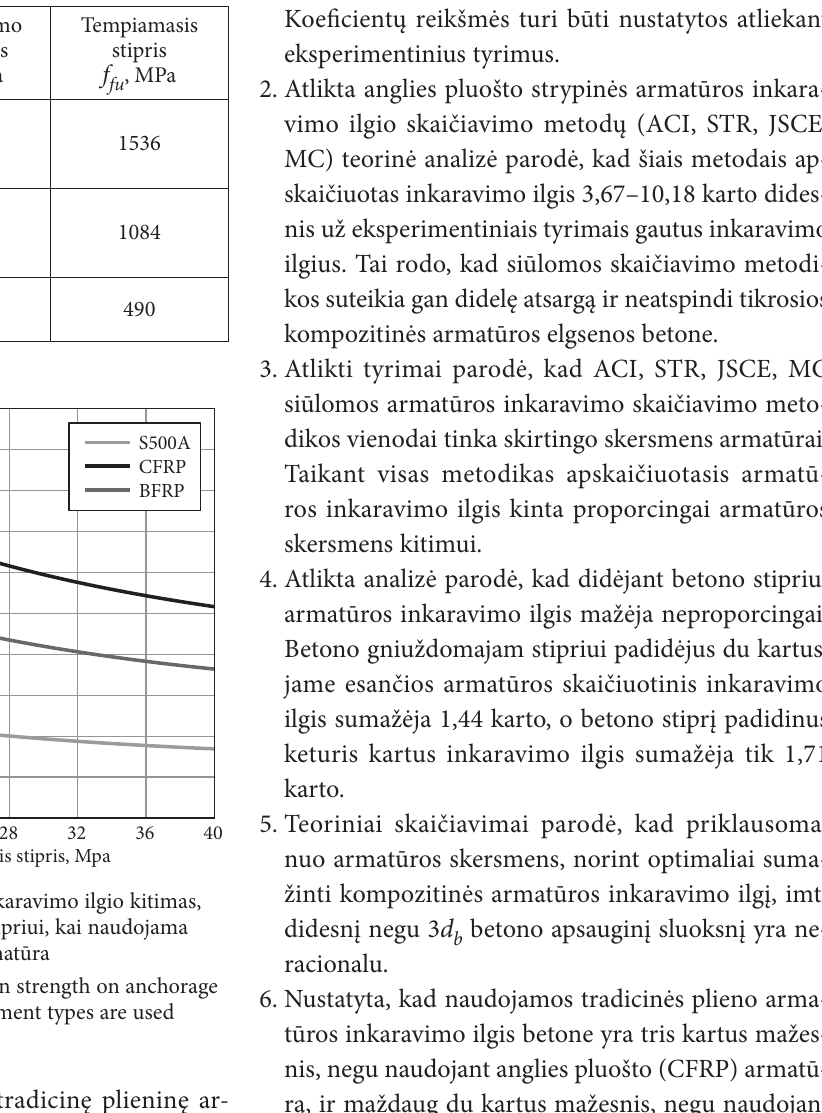
Table 3. Mechanical properties of reinforcement types